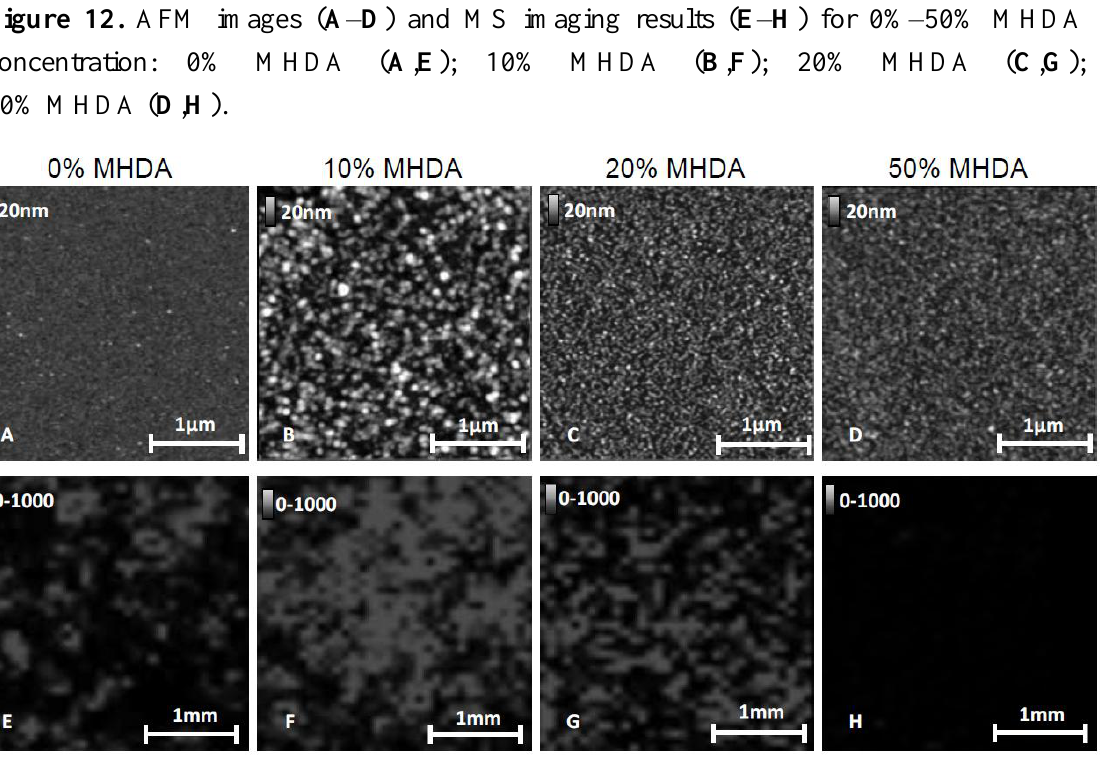
Figure 12. AFM images ( A – D ) and MS imaging results ( E – H ) for 0%–50%